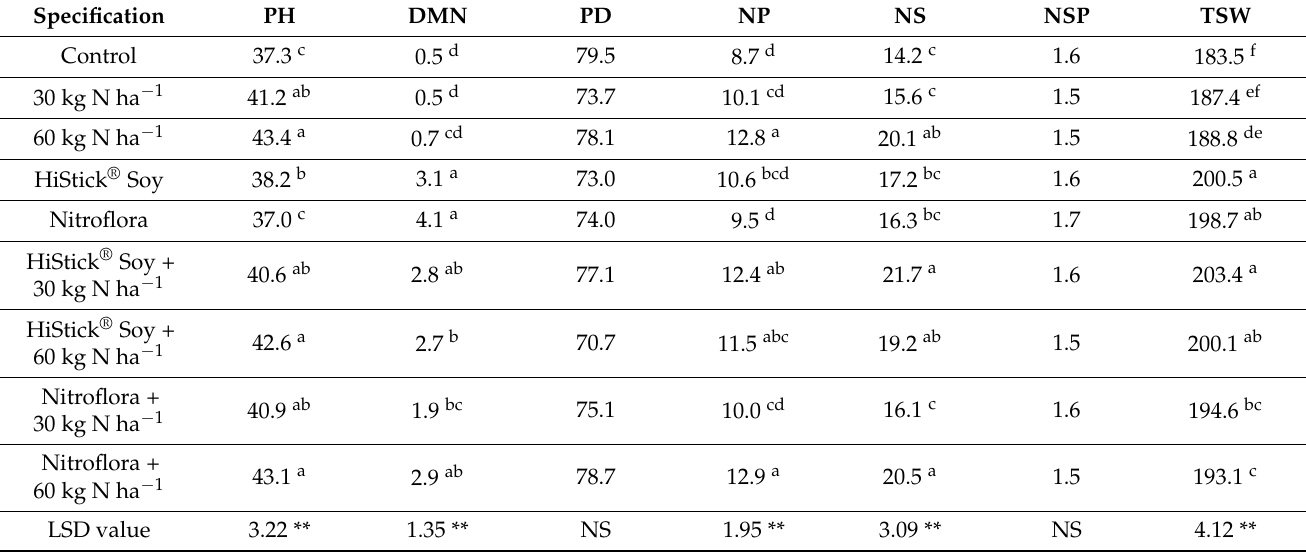
Table 4. The effect of N supply and inoculation on biometrical features and yield